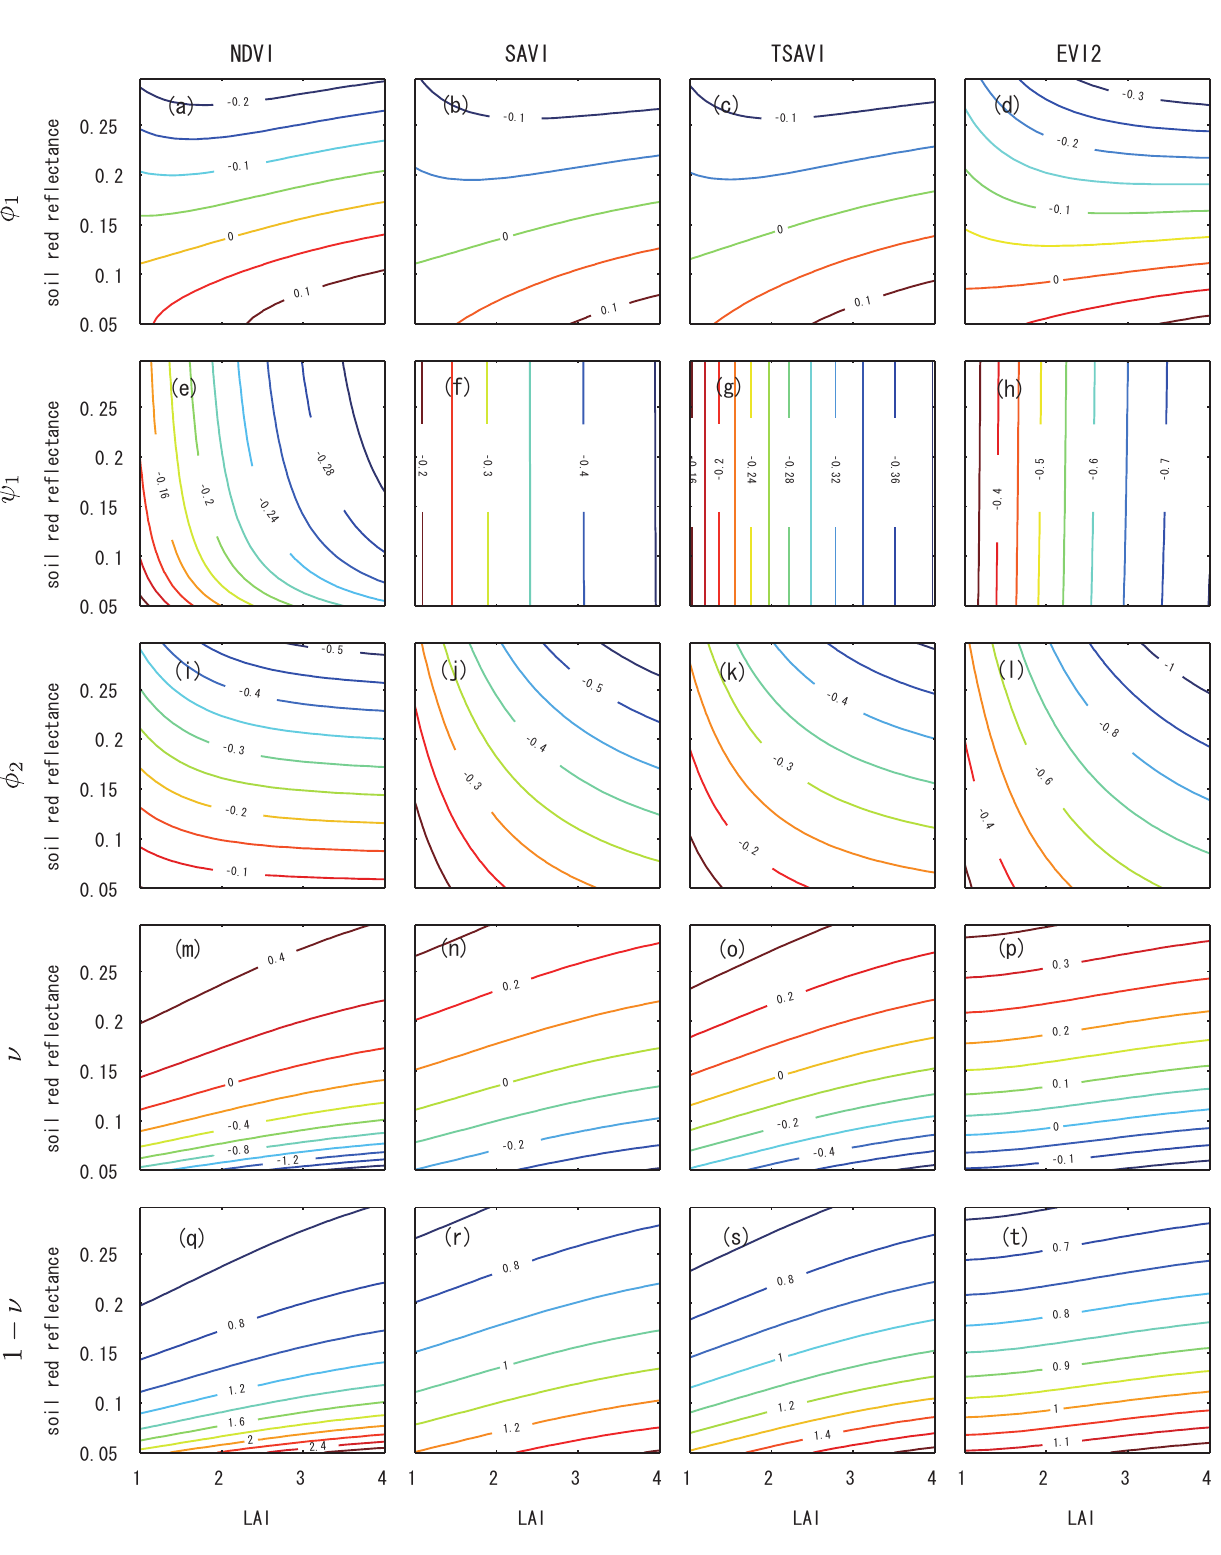
Figure 8 . Variations of ϕ , ψ , ϕ , ν , and 1 − ν as a function of vegetation and non-vegetation 1 1 2 endmember spectra represented by LAI and soil red reflectance, respectively. The plots are arranged in a matrix form, where the choice of VI is arranged column-wise, and the five coefficients are arranged